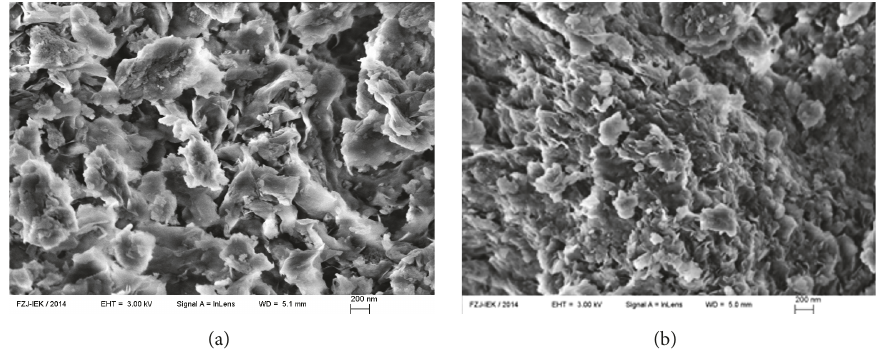
Figure 1: SEM image of natural MM (a) and Al 30 -pillared MM (b)